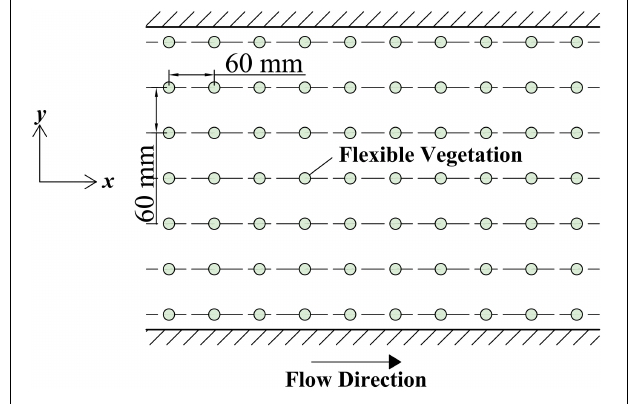
FIGURE 2 | Vegetation arrangement diagram.